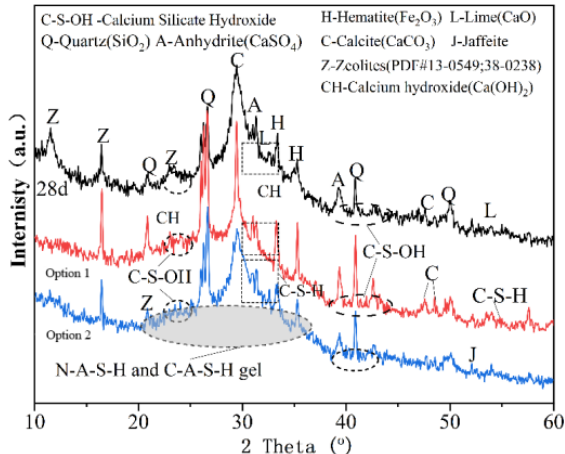
Figure 10. X-ray diffraction patterns of Scheme 1, Scheme 2, and 28 − day optimal proportioning sample.